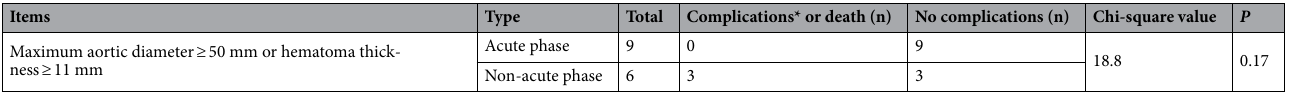
Table 5. Comparison of the therapeutic effect of acute and non-acute endovascular treatment for maximal aortic diameter ≥ 50 mm or hematoma thickness ≥ 11 mm. *Progression of aortic dissection, pseudoaneurysm, rupture, visceral arterial perfusion, lower limb ischemia.